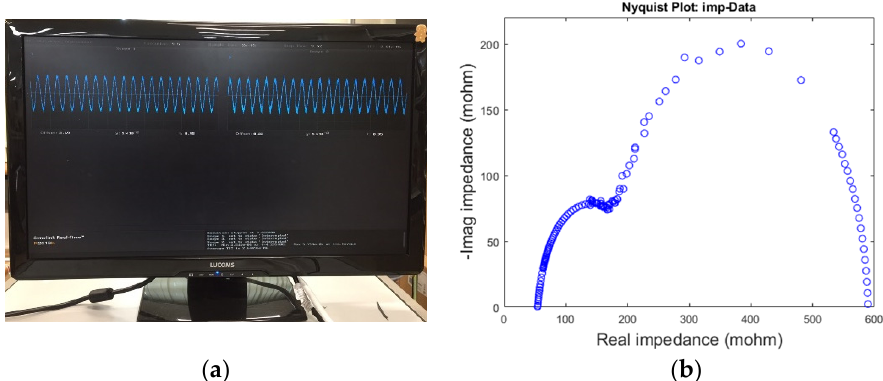
Figure 7. Real-time simulation of models in target machine and Nyquist plot. ( a ) Waveform of target scope. ( b ) Nyquist plot by real-time operation.